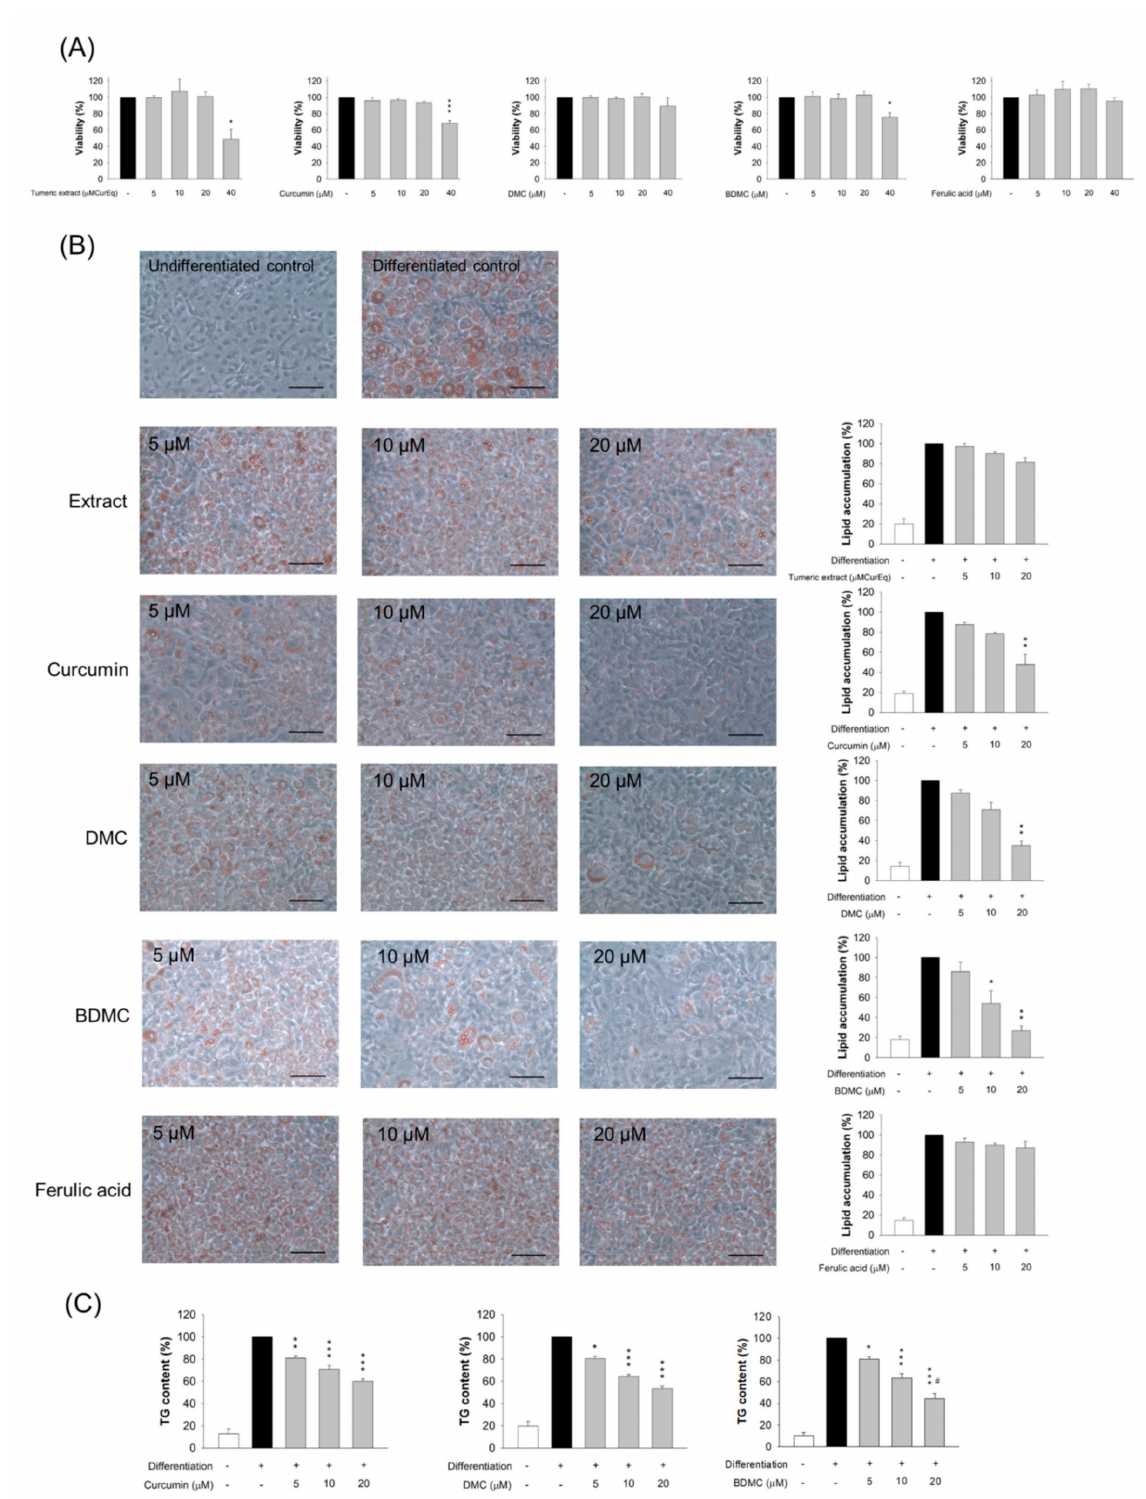
Figure 3. The 3T3-L1 cell viability and lipid accumulation after treatment of turmeric extract, curcuminoids, and ferulic acid. ( A ) The cell viability determined by MTT assay; ( B ) the ORO staining and the quantification of 3T3-LI cells; and ( C ) the intracellular TG content of 3T3-LI cells. All data are presented as the mean of three experiments ± S.E.M. *** p < 0.001; ** p < 0.01; * p < 0.05 as compared to the differentiated control group. # p < 0.05 as compared to the curcumin-treated group at the same